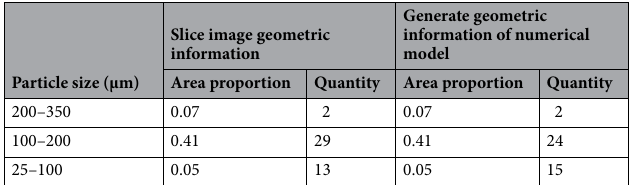
Table 3. Statistical particle grading and modeled particle grading.